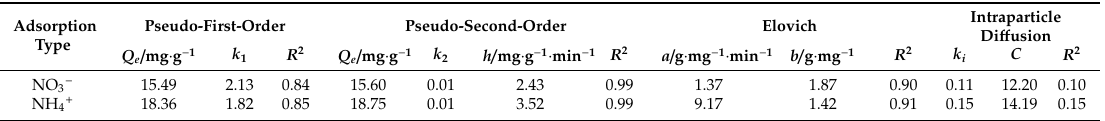
Table 5. Kinetic model parameters of NO 3 − and NH 4 + by